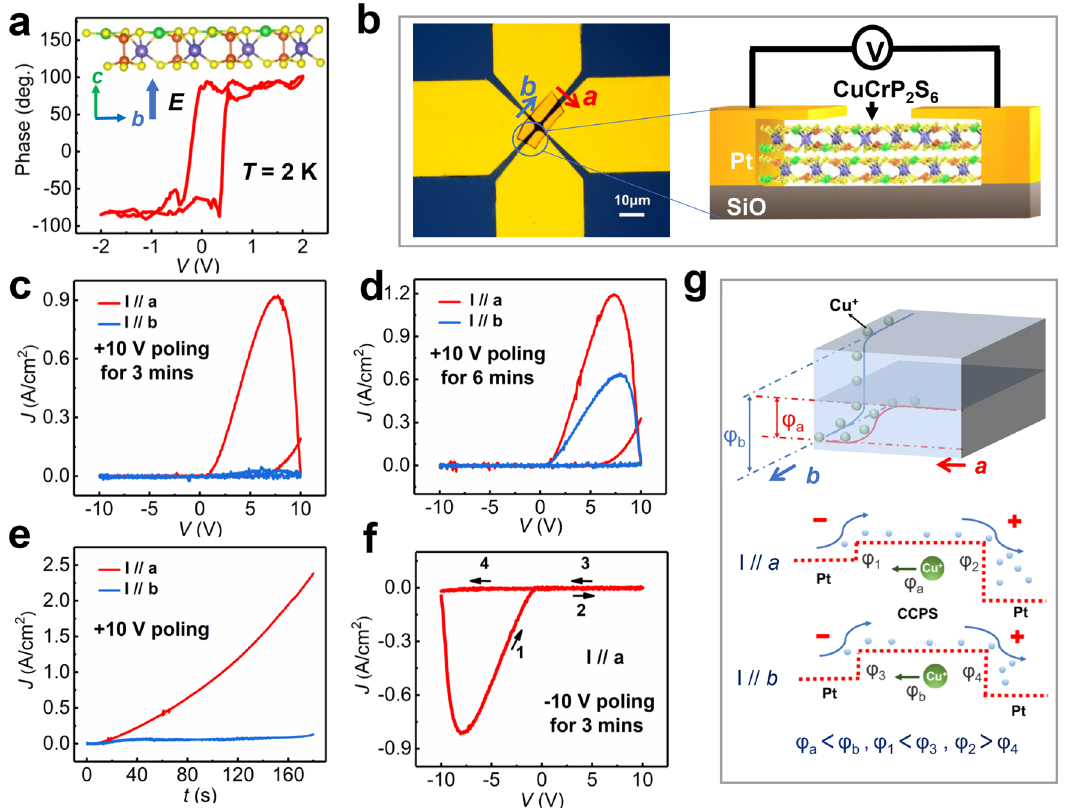
Fig. 2 | Electrical measurements of the AFE CCPS indicating local FE polariza- tion and electrical anisotropy. a Phase vs voltage hysteresis loop of CCPS crystal bulkobtainedat T =2KbyPFM,aftersubtracting thebuilt-inelectric fi eldbetween the sample and substrate. The upper inset diagram indicates the atomic structure ofelectric fi eld( E )drivenFEpolarizedstate. b ThemicroscopepictureofourCCPS device with identi fi ed a and b axes, along with the scale-up con fi guration of